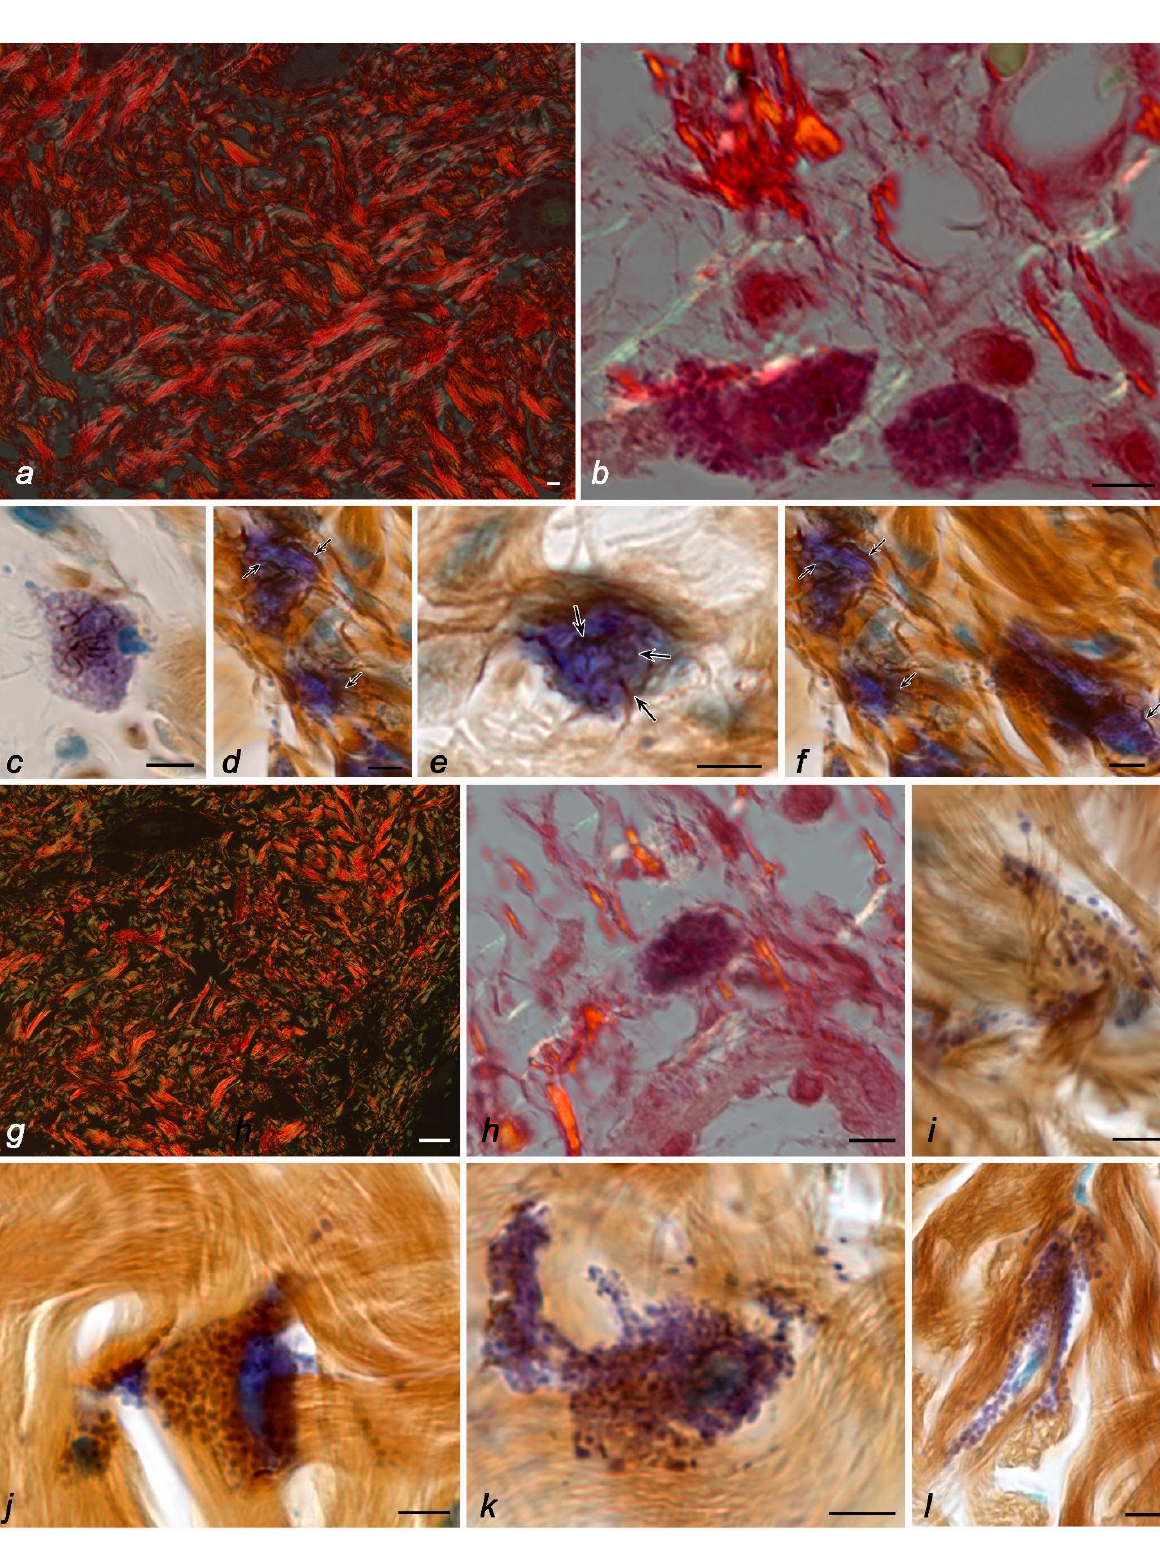
Figure 1. The fibrous component of the extracellular matrix and mast cells in the skin of the thigh of C57BL/6J mice. Groups of vivarium control ( a , c , d , f ), ground control ( b , e ), and space flight ( g – l ). Techniques: staining with picrosirius red ( a , g ), picrosirius red, and Giemsa solution ( b , h ), impregnation with silver and toluidine blue ( c – f , i – l ). Notes : ( a ) visualization of the dermis in polarized light: fibers containing type-I (fluorescently labeled red regions) and -III collagens (fluorescently labeled green regions). ( b ) Fibers containing type-III collagen (fluorescently labeled green regions, indicated by an arrow) in the local microenvironment of mast cells (indicated by a double arrow), fibers containing type-I collagen are red. ( c – f ) Different distributions of fine precollagen fibers